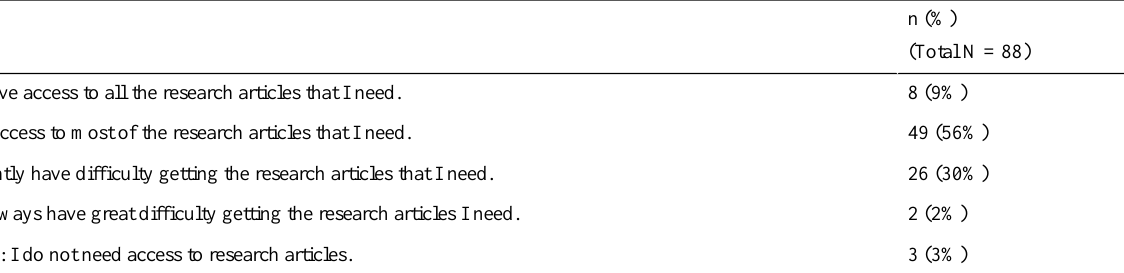
Table 1. Perceived quality of access